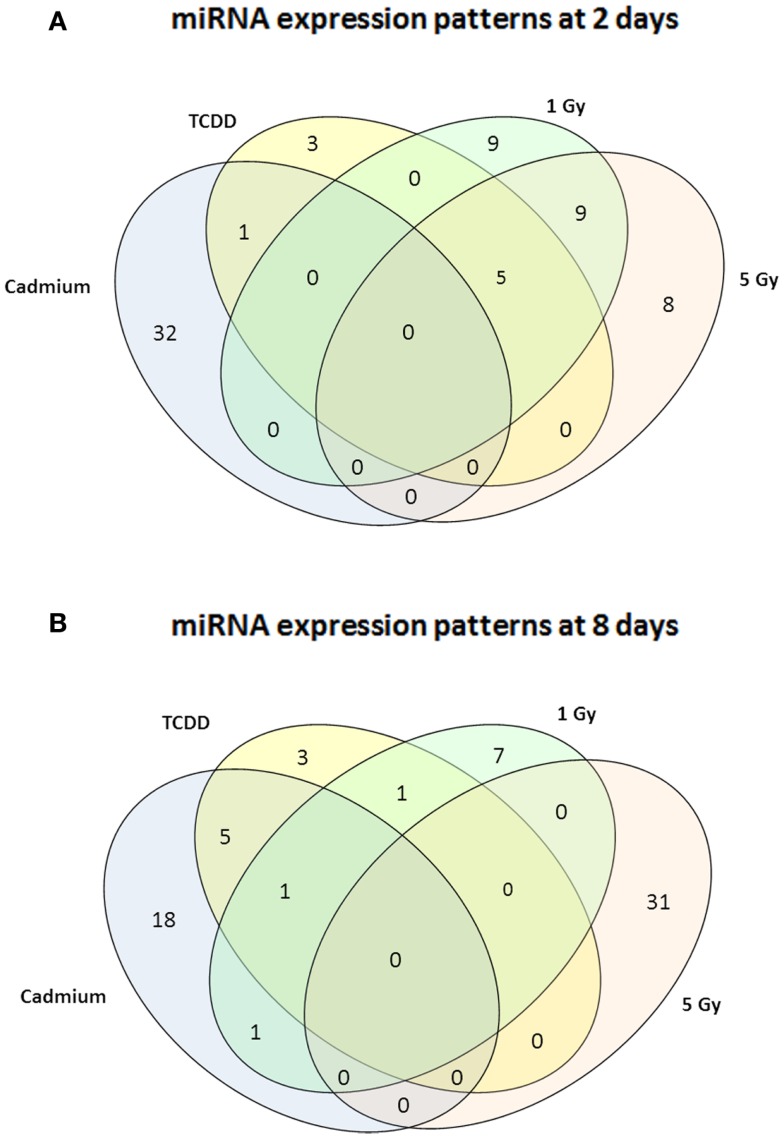
A Venn diagram showing the number of miRNA – species with altered expression at 2 days (A) or 8 days (B). Greater than or equal to 1.50-fold changes in the same direction are presented as common changes.